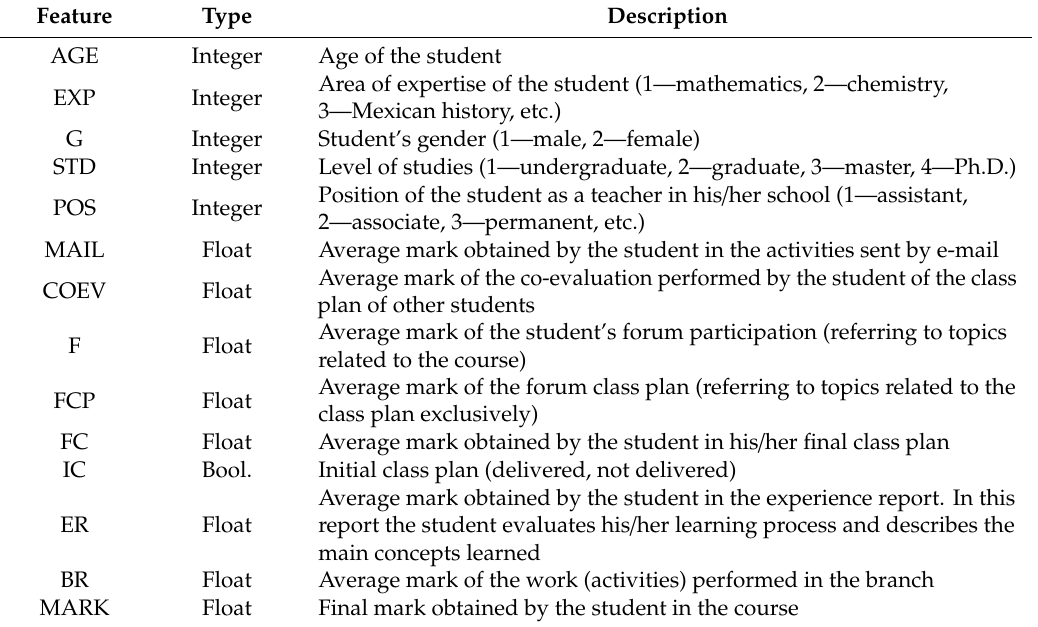
Table 1. Data features collected for the didactic planning